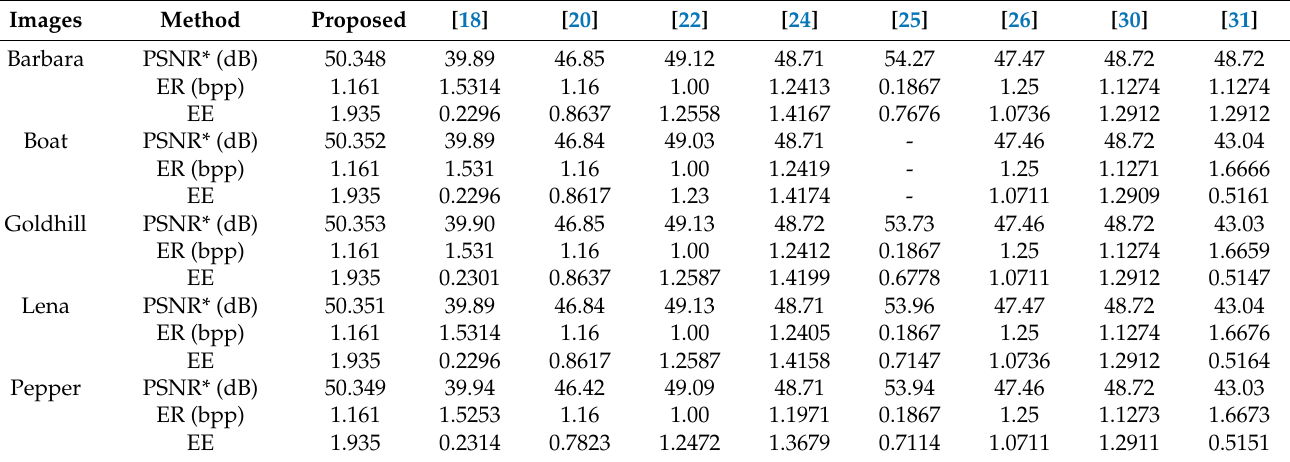
Figure 13. The visual inspection results of four types of attack and the corresponding restored image. Table 16. Comparison results in terms of PSNR, embedding rate, and embedding